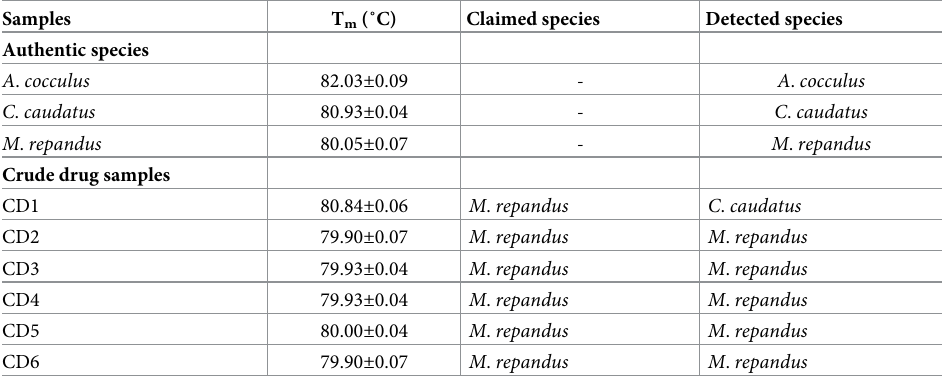
Table 4. Bar-HRM analysis showing the T m (˚C) of authentic plant species and purchased crude drug samples.